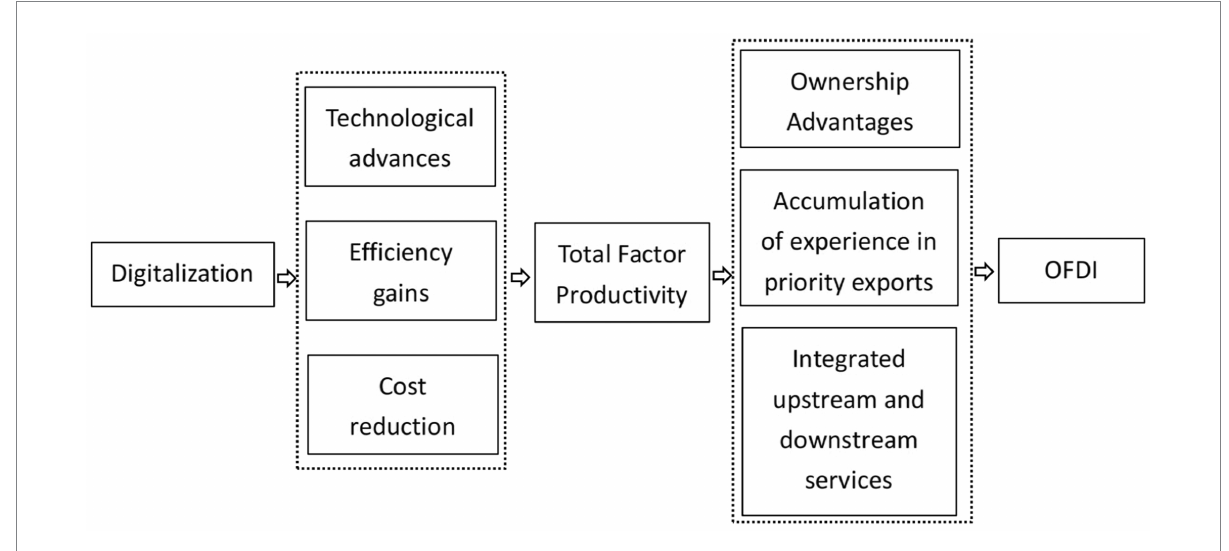
FIGURE 2 The mediating role of total factor